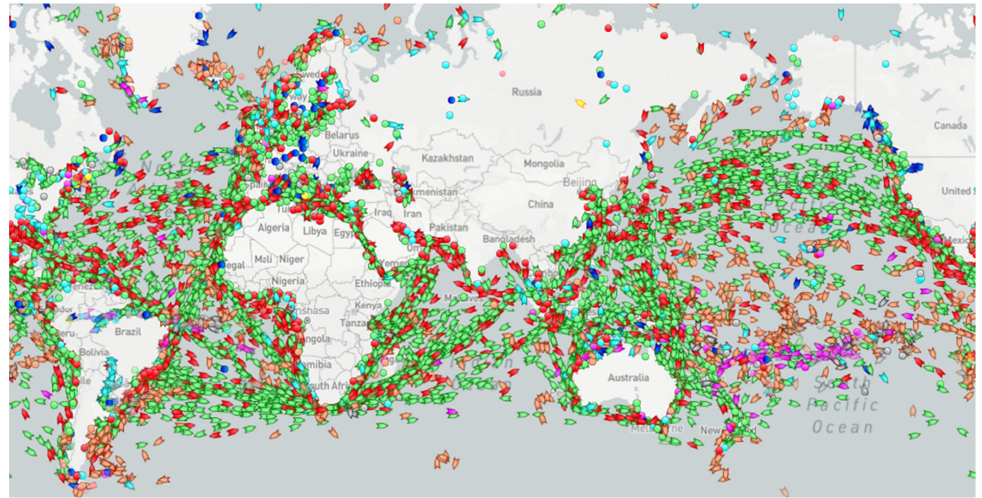
Figure 28. A snapshot of merchant shipping vessel locations as reported via AIS. (Map courtesy of MarineTraffic, [107]). Colors indicate type of vessel, e.g., red for tankers, green for cargo ships, pink for fishing boats.